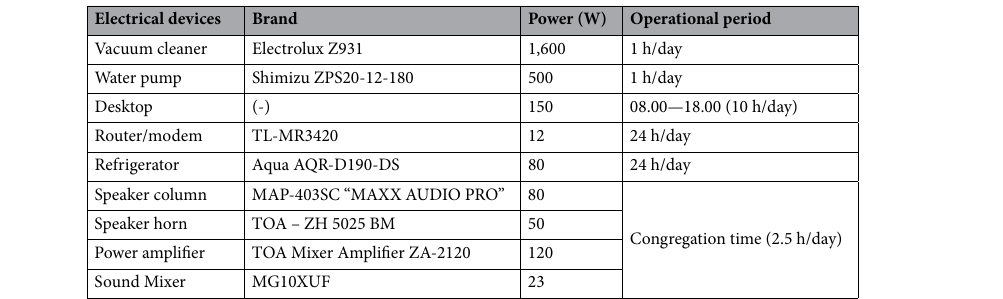
Table 3. Electrical appliances power and operational